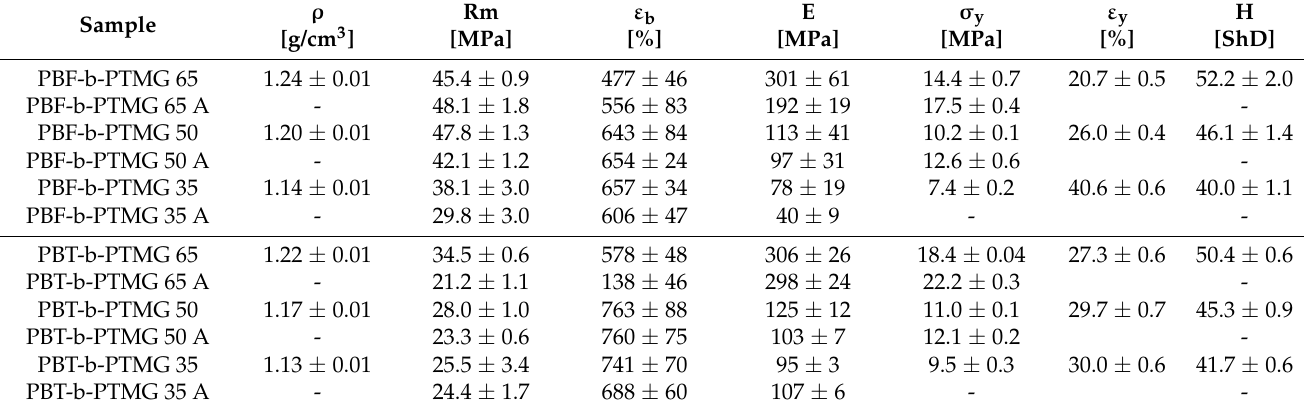
Table 3. Mechanical parameters of PBF and PBT based